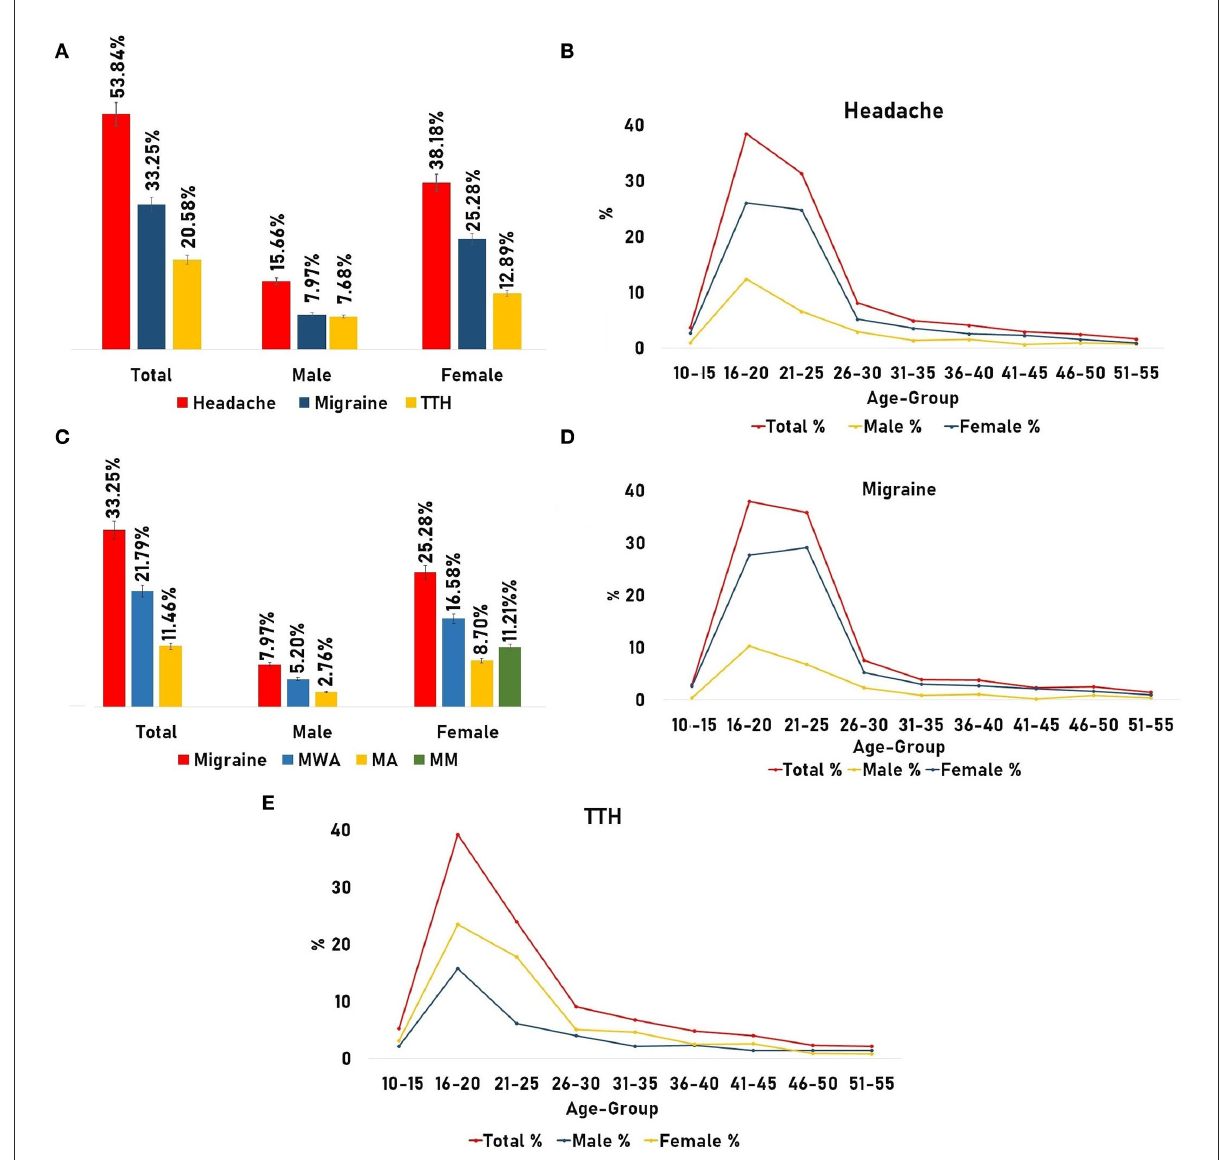
FIGURE4 Prevalence of headache and its types. (A) Prevalence of headache with migraine and tension-type headaches (TTH) adjusted for gender. (B) Age and gender-adjusted prevalence of headache. (C) Prevalence of migraine and its type [Migraine Without Aura (MWA) and Migraine with Aura (MA)] adjusted for gender. (D) Age and gender-adjusted prevalence of migraine. (E) Age and gender-adjusted prevalence of